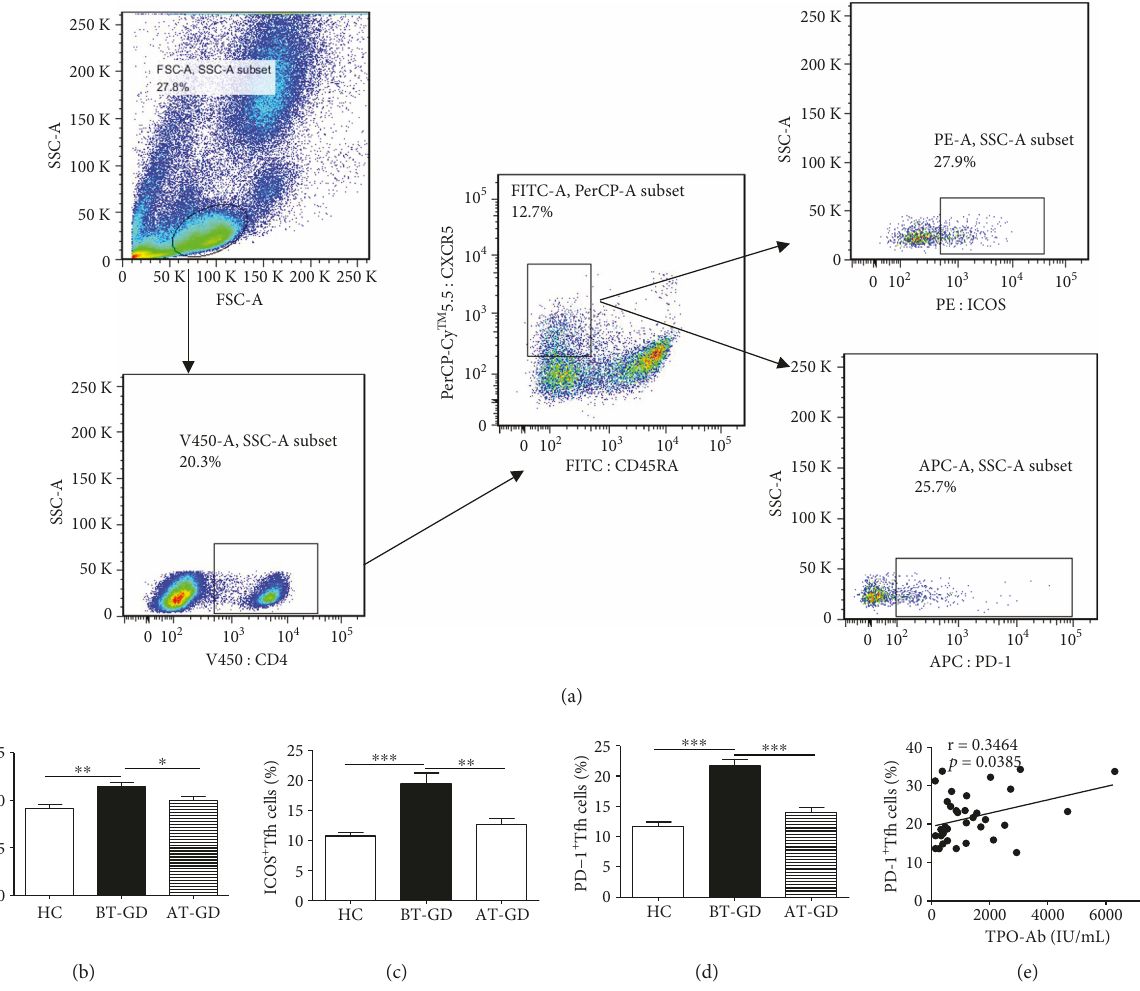
Figure 1: Flow analysis of circulating Tfh cells in GD patients. Human PBMCs from GD patients (BT: 36; AT: 21) and 20 HC were stained with anti-CD4, anti-CXCR5, anti-ICOS, anti-CD45RA, and anti-PD-1. (a) The cells were gated initially on lymphocytes and then circulating Tfh cells were analyzed by fl ow cytometry; (b) the numbers of circulating CD4 + CXCR5 + CD45RA − Tfh (cTfh) cells; (c) the numbers of CD4 + CXCR5 + CD45RA − ICOS + T cells; (d) CD4 + CXCR5 + CD45RA − PD-1 + Tfh cells; (e) the correlation between PD-1 + Tfh cell proportions and TPO-Ab levels in GD patients. ∗ p < 0 05 , ∗∗ p < 0 01 , and ∗∗∗ p < 0 001 ; ns: no signi fi cant di ff